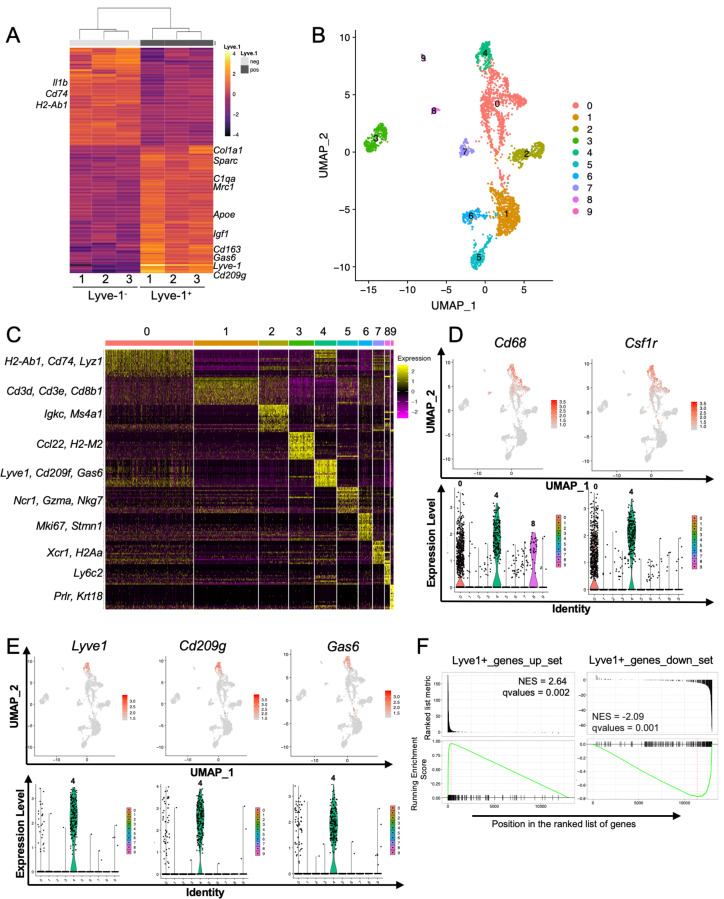
Identification of a distinct Lyve-1+ macrophage subpopulation by transcriptional profiling.(A) Heat map of RNA-seq analysis of CD45+CD11b+F4/80+Lyve-1– and CD45+CD11b+F4/80+Lyve-1+ cells isolated from 6-week-old (lane 1) and 10-week-old (lanes 2–3) mice. Genes shown have an adjusted p-value <0.01 and a fold-change of >1 and <10 (abs values). For each lane, n = 4 pooled mice. (B) UMAP of scRNA-seq analysis of CD45+ cells isolated from 10-week-old mice as generated by Seurat. (C) Heat map of the top 20 differentially regulated genes in each cluster. (D) Feature plots and violin plots of selected macrophage genes. (E) Feature plots and violin plots of genes associated with cluster four that were also found in the bulk RNA-seq analysis. (F) GSEA demonstrating that the single-cell populations (clusters) are enriched for in the data from the bulk RNA-seq analysis.